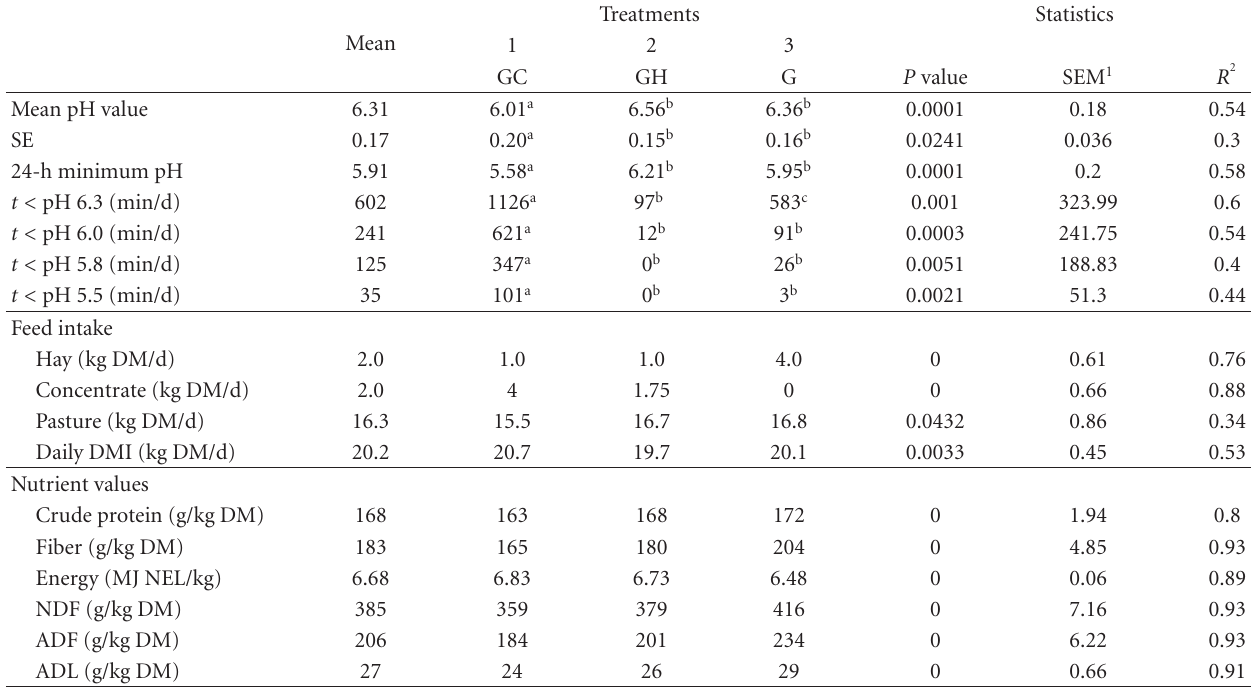
Table 2: E ff ects of di ff erent dietary treatments (GC, GH, and G) on reticuloruminal pH, standard deviation, mean of daily minimum (nadir), and the time (min/d) pH were below 6.3, 6.0, 5.8, and